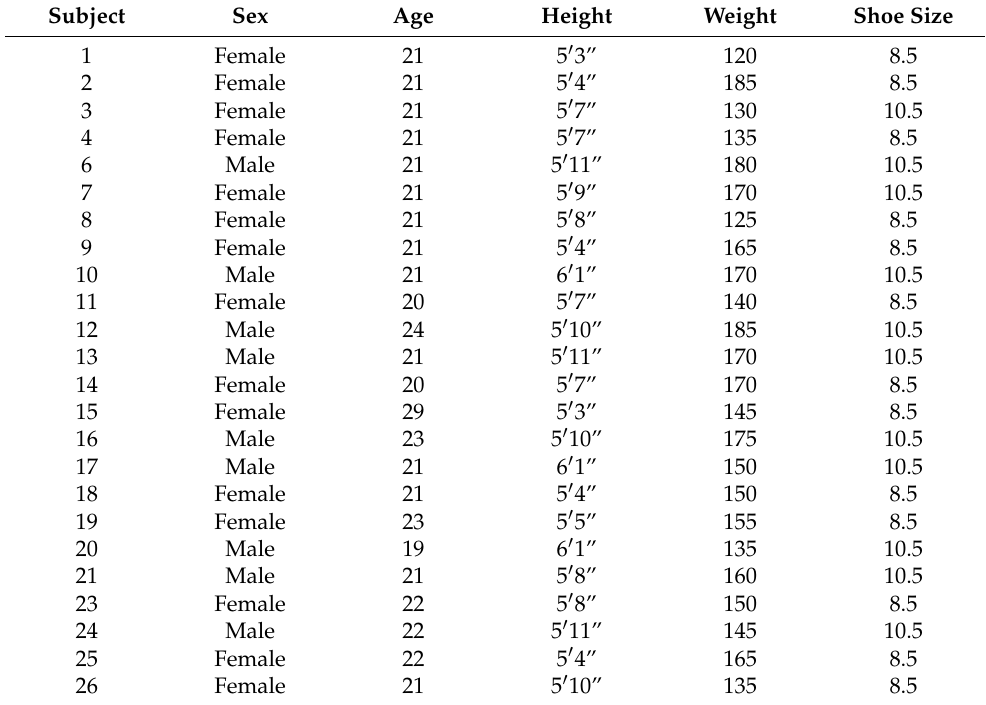
Table 1. Participant